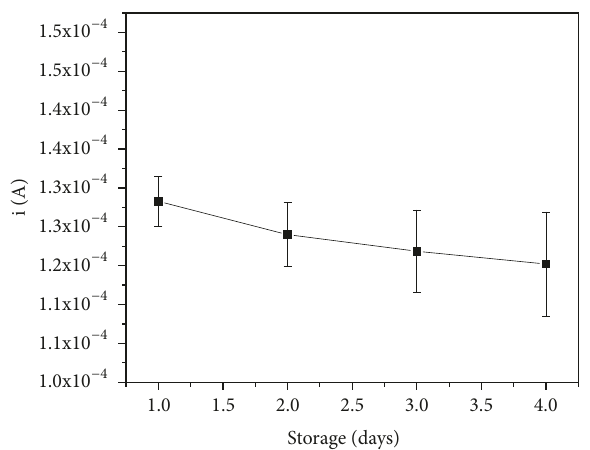
Figure 7: The differential pulse voltammetric response of DMF modified SPCE for 1 mM uric acid in a 0.1 M PBS (pH 7) during storage for four consecutive